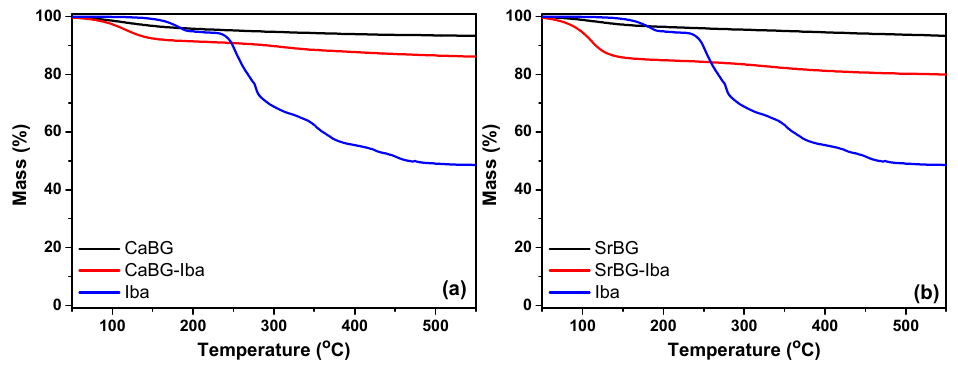
Figure 7. TGA thermograms of Iba and ( a ) CaBG, ( b ) SrBG before and after Iba adsorption.